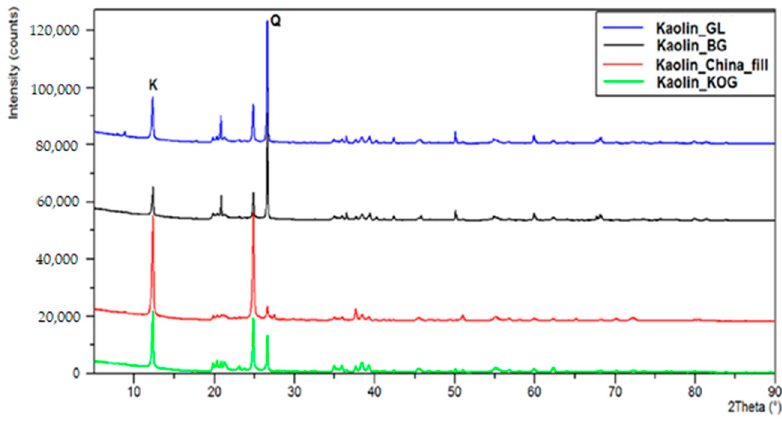
Figure 10. Diffractograms of kaolin carriers sourced from various mines.